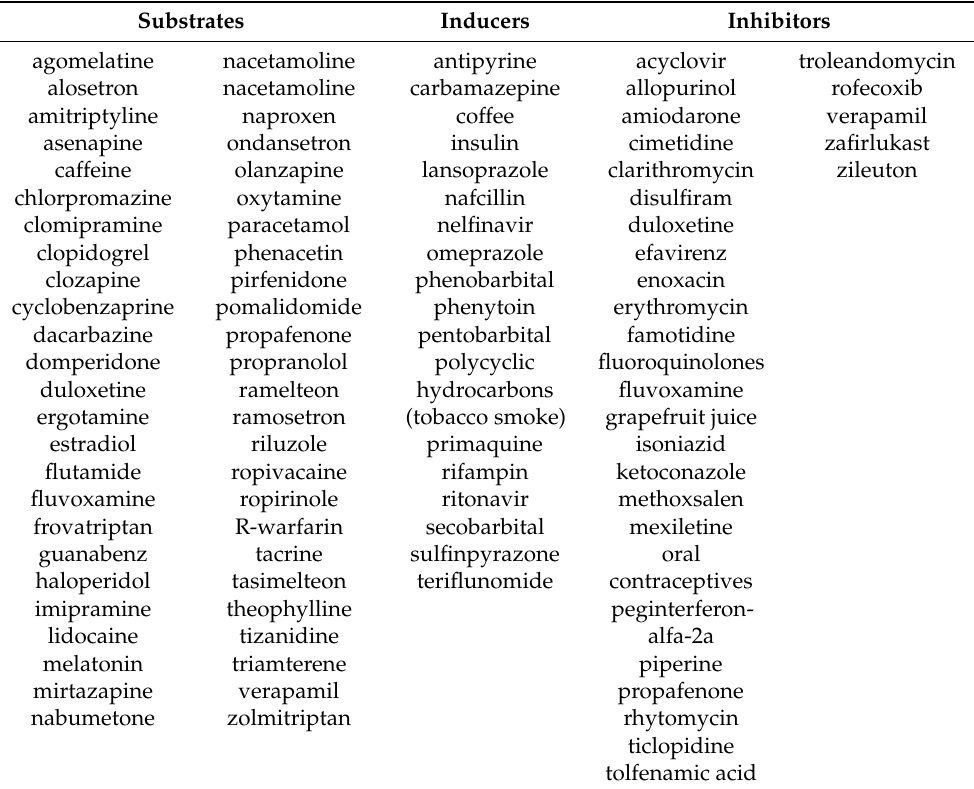
Table 1. List of CYP1A2 substrates, inducers and